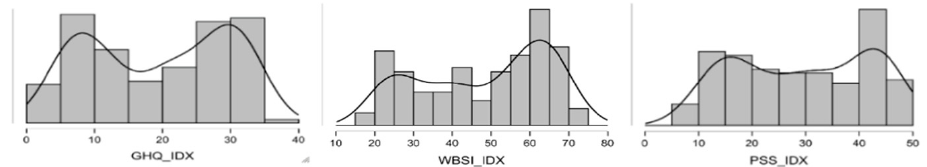
Figure 2. Distribution of the scores of 6-PAQ and its subscales. Note: GHQ_IDX: GHQ total score;